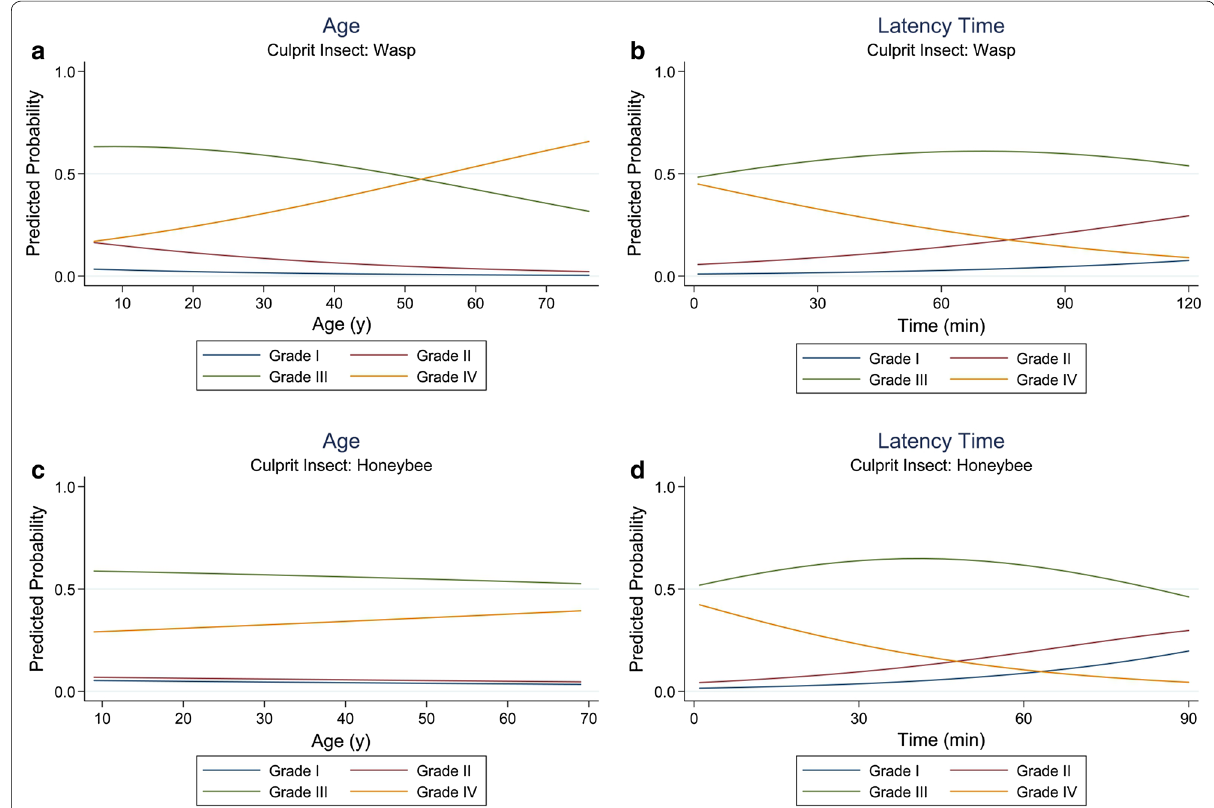
Fig. 2 a Association between age and grade for wasp venom allergic patients. b Association between latency time and grade for wasp venom allergic patients. c Association between age and grade for honeybee venom allergic patients. d Association between latency time and grade for honeybee venom allergic